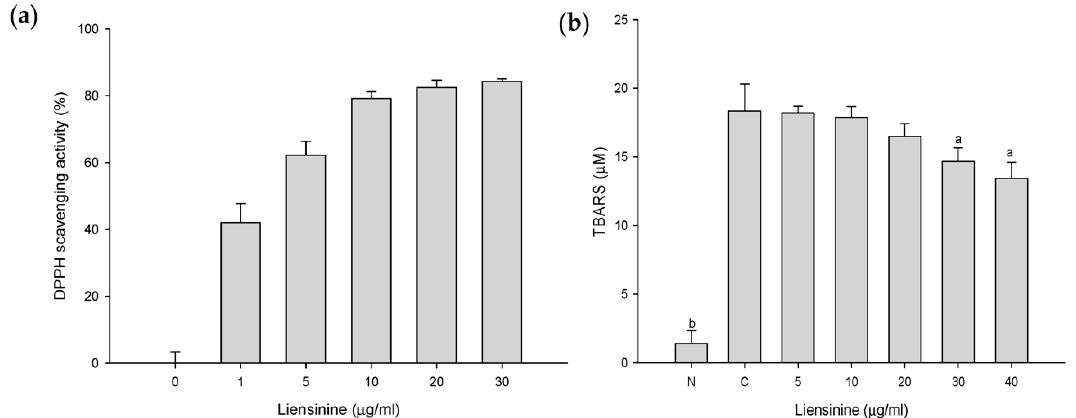
Figure 2. The antioxidant potency of liensinine. ( a ) 1,1-diphenyl-2-picrylhydrazyl (DPPH) free radical scavenging activity (IC 50 = 1.8 μ g/mL and r 2 =0.94) ( b ) Serum lipid peroxidation inhibitory activity. N represents the normal group (without copper sulphate). a p < 0.05 and b p < 0.01 vs. C (the control group; presence of copper sulfate only). n = 3 replicates.